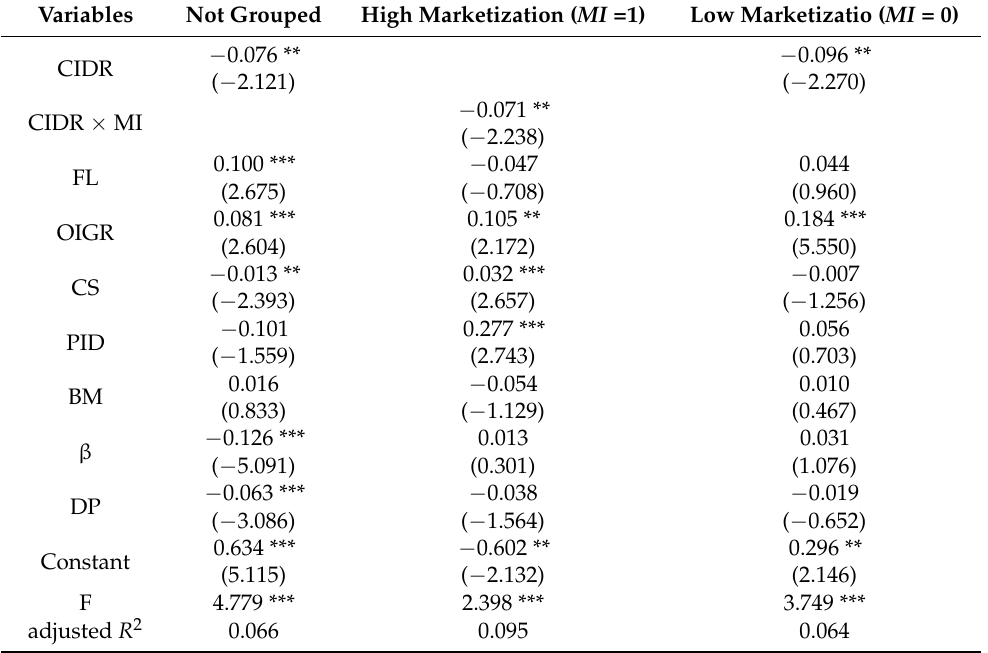
Table 6. Robustness test